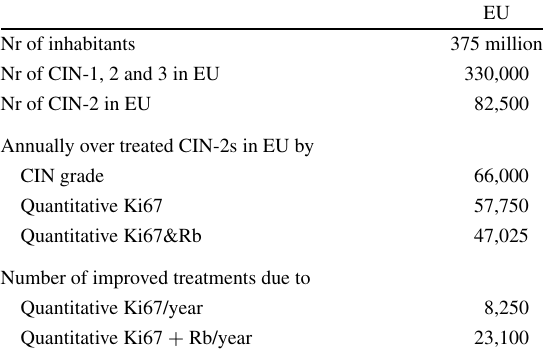
The estimated annual number of patients with CIN, and over- treatments in the European Union